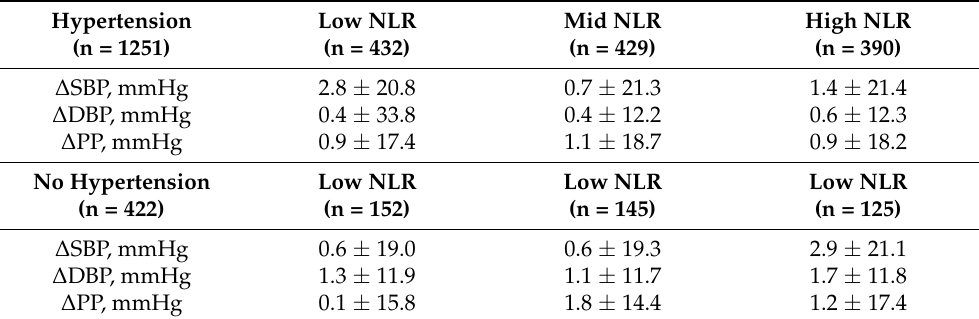
Table 2. Mean change of blood pressure values across tertiles of NLR in individuals with and without